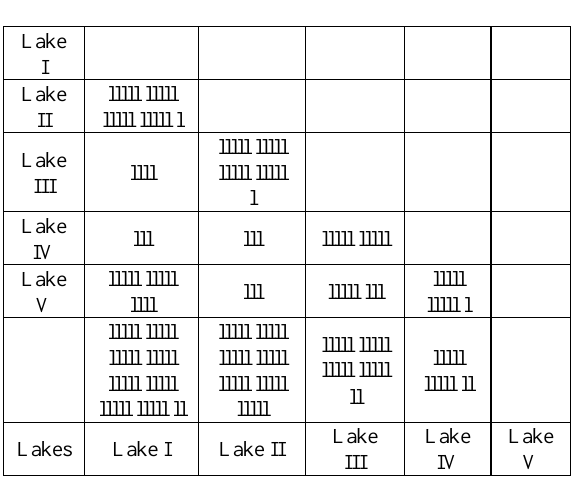
Figure 6. Lakewise distribution of plant types Table 5. Location wise distribution of aquatic plants